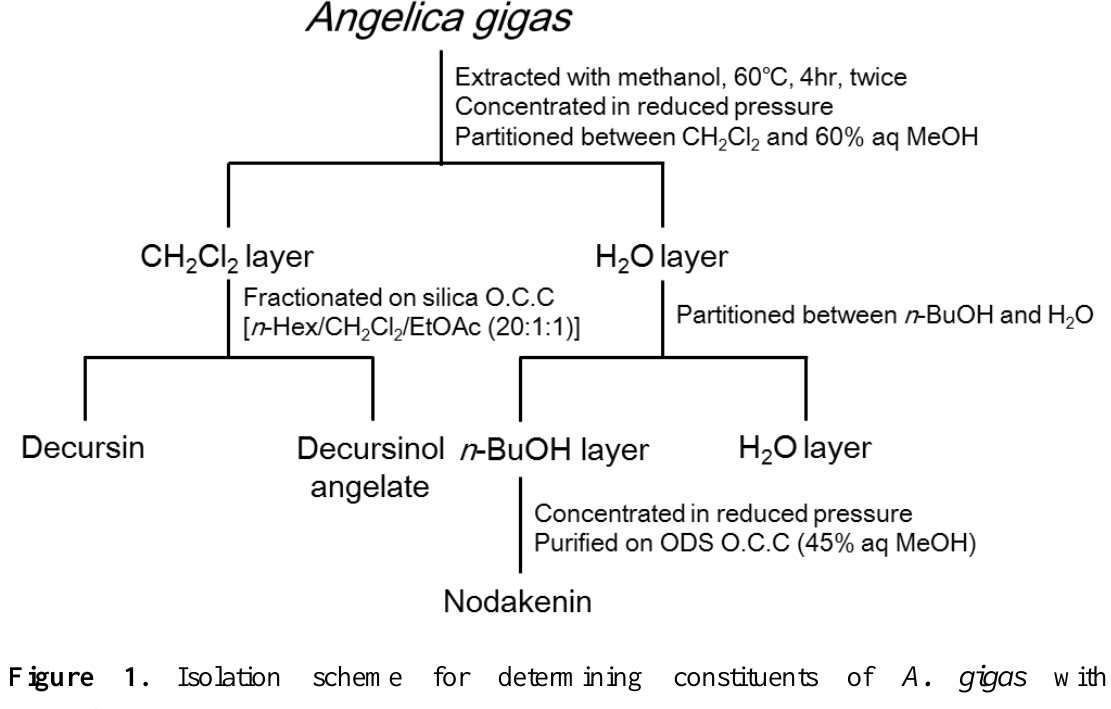
Figure 1. Isolation scheme for determining constituents of A. gigas with anti-inflammatory